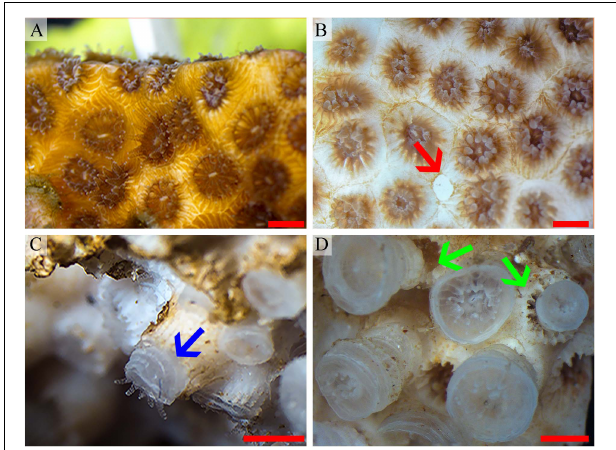
FIGURE 2 | O. patagonica macromorphology. O. patagonica images representing the bleaching process and the skeletal macromorphology transformation throughout the time of the experiment. Day 1, fully pigmented colony (A) , day 30, loss of the colony pigmentation and degradation of the coenosarc (red arrow) (B) , day 350 (C) and day 500 (D) . Blue arrow points to region of growth of the theca and green arrows highlight differences in the overlap of the newly formed thecae as compared with the shape formed in the ambient condition. Scale bar = 2 mm.